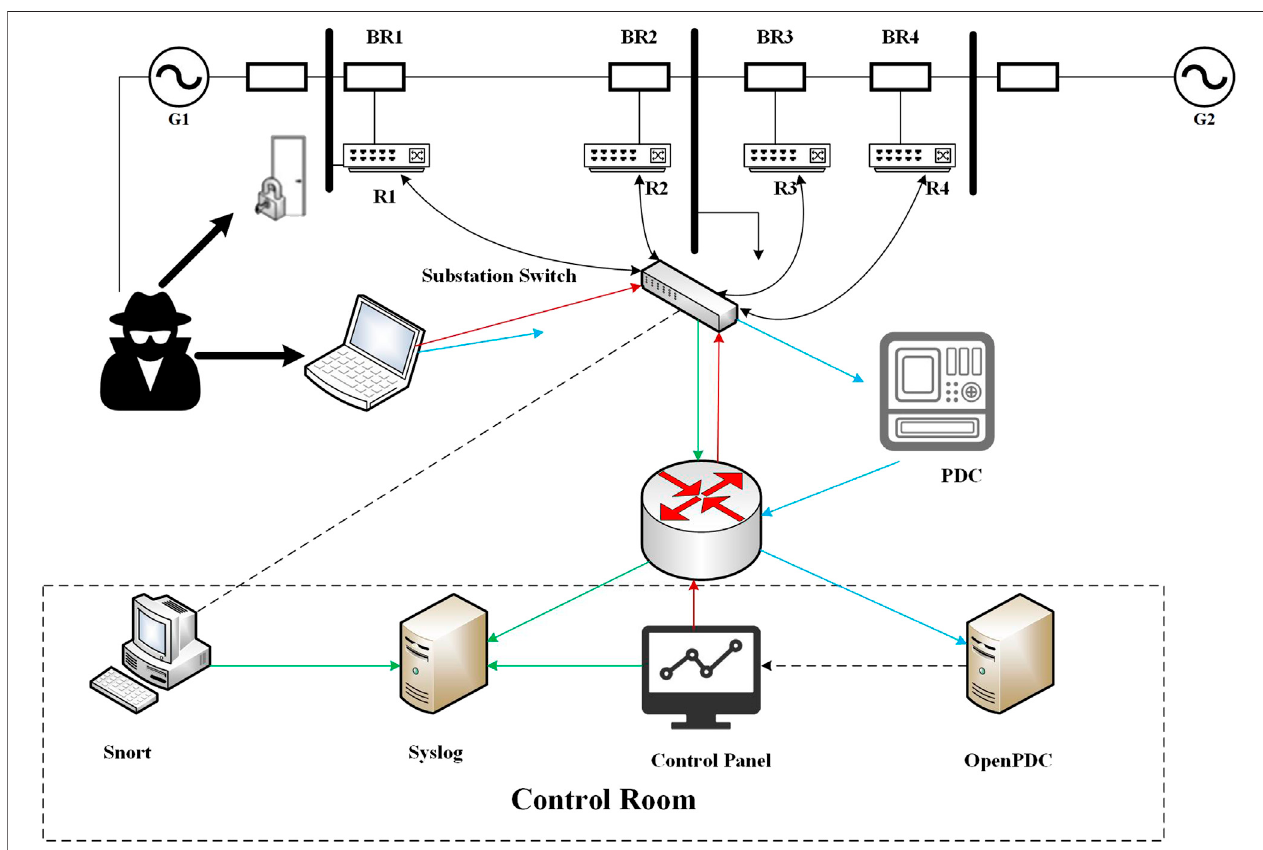
FIGURE 2 | ICS structure.